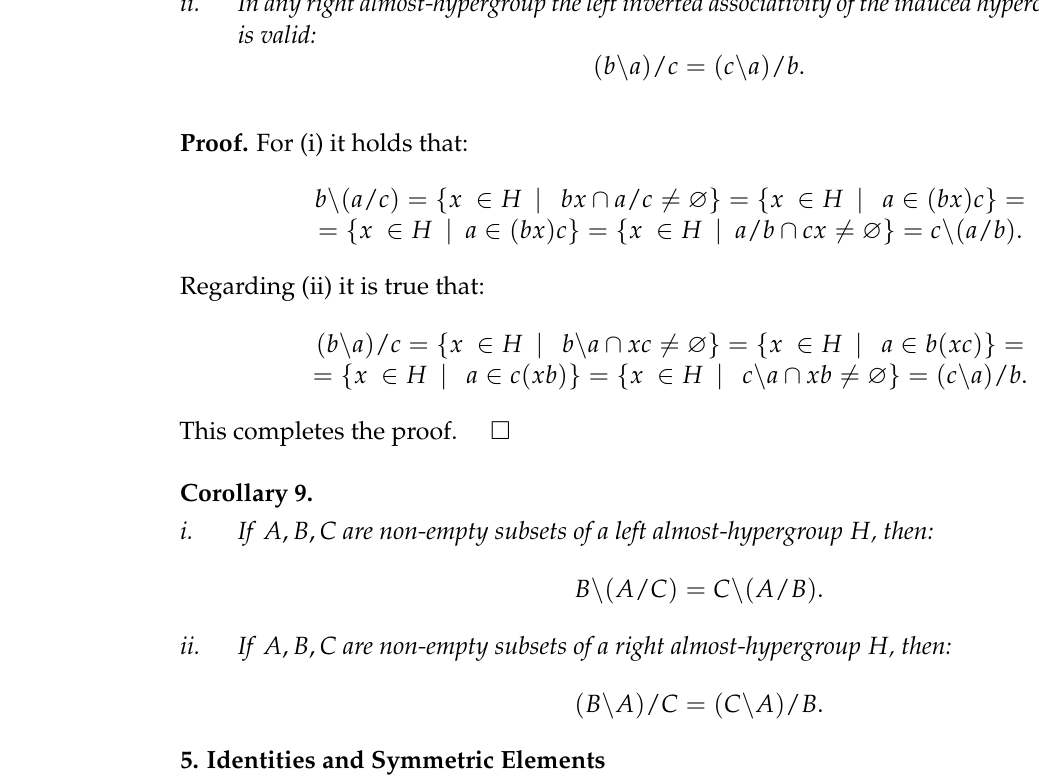
Table 17. Left almost-hypergroup with left scalar identity.